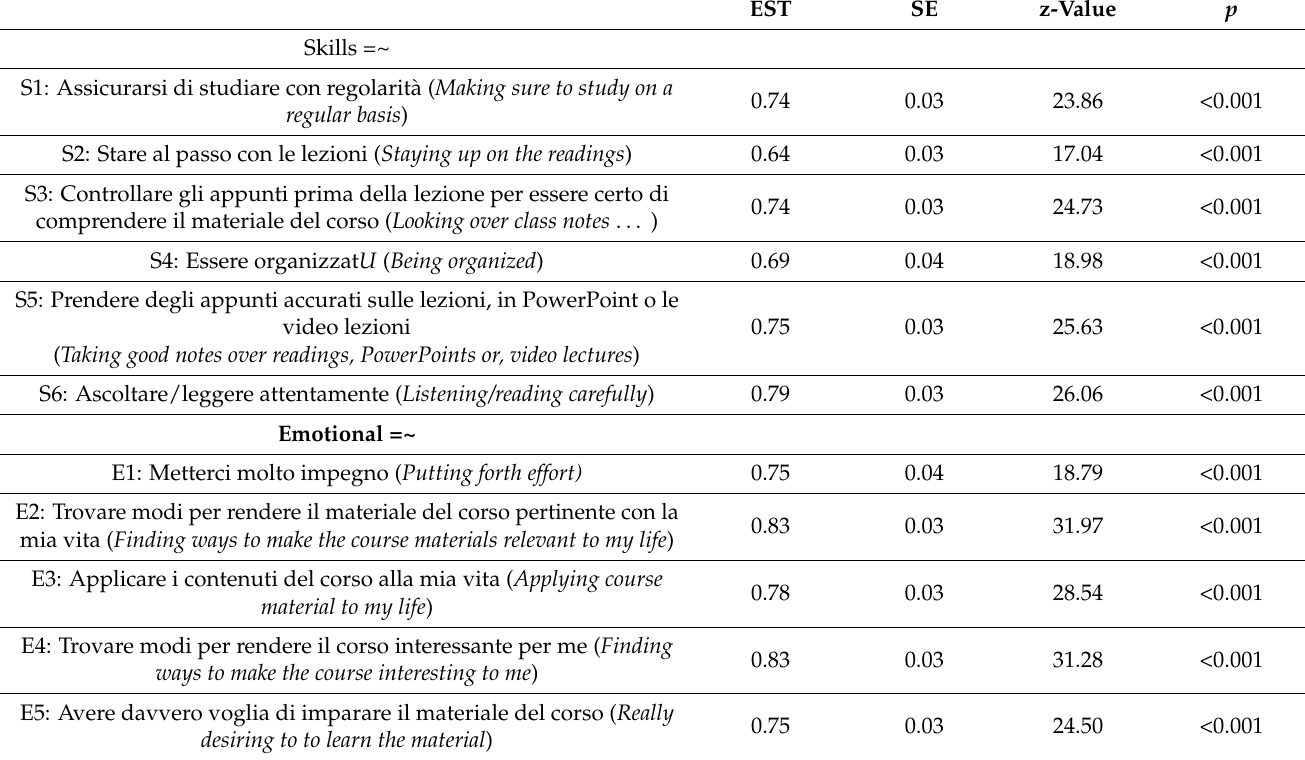
Table 3. Results of CFA: Estimates (EST), Standard Error (SE), z-value and significance ( p ) values are reported for each item of the OSE scale (the original item is reported in